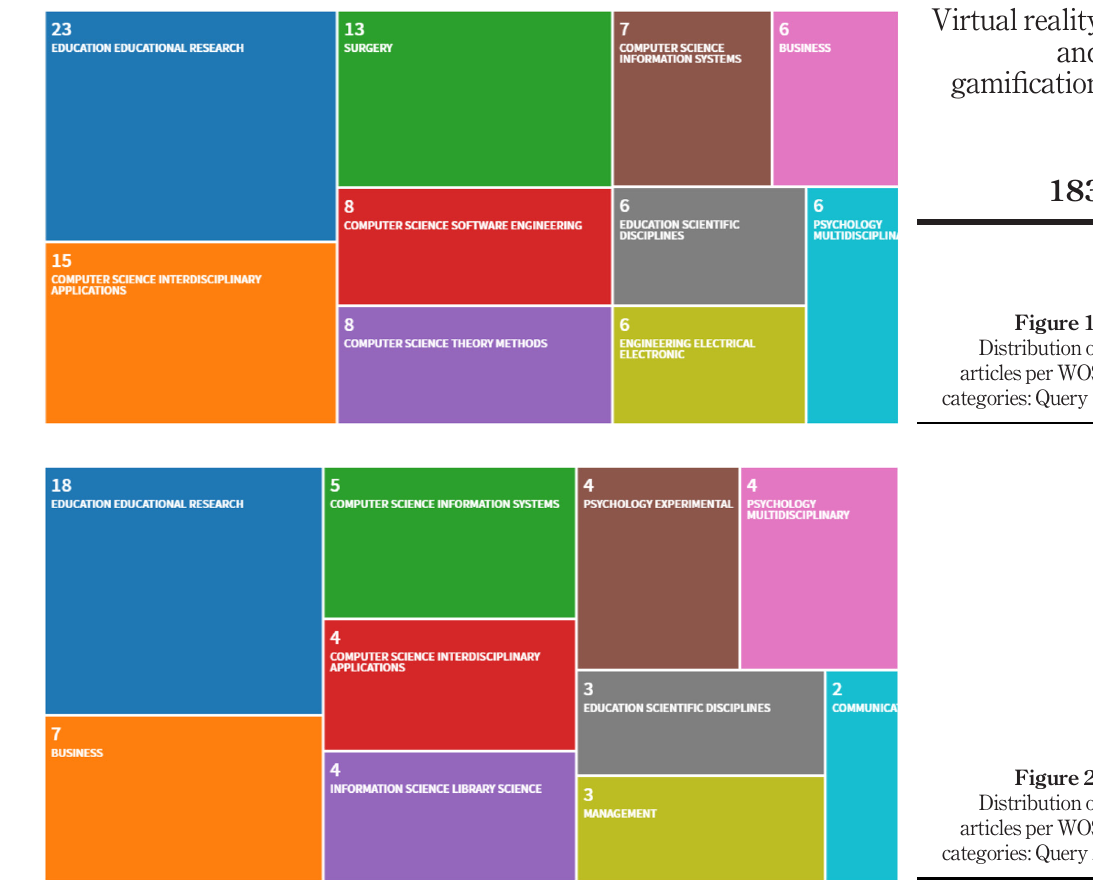
Figure 2. Distribution of